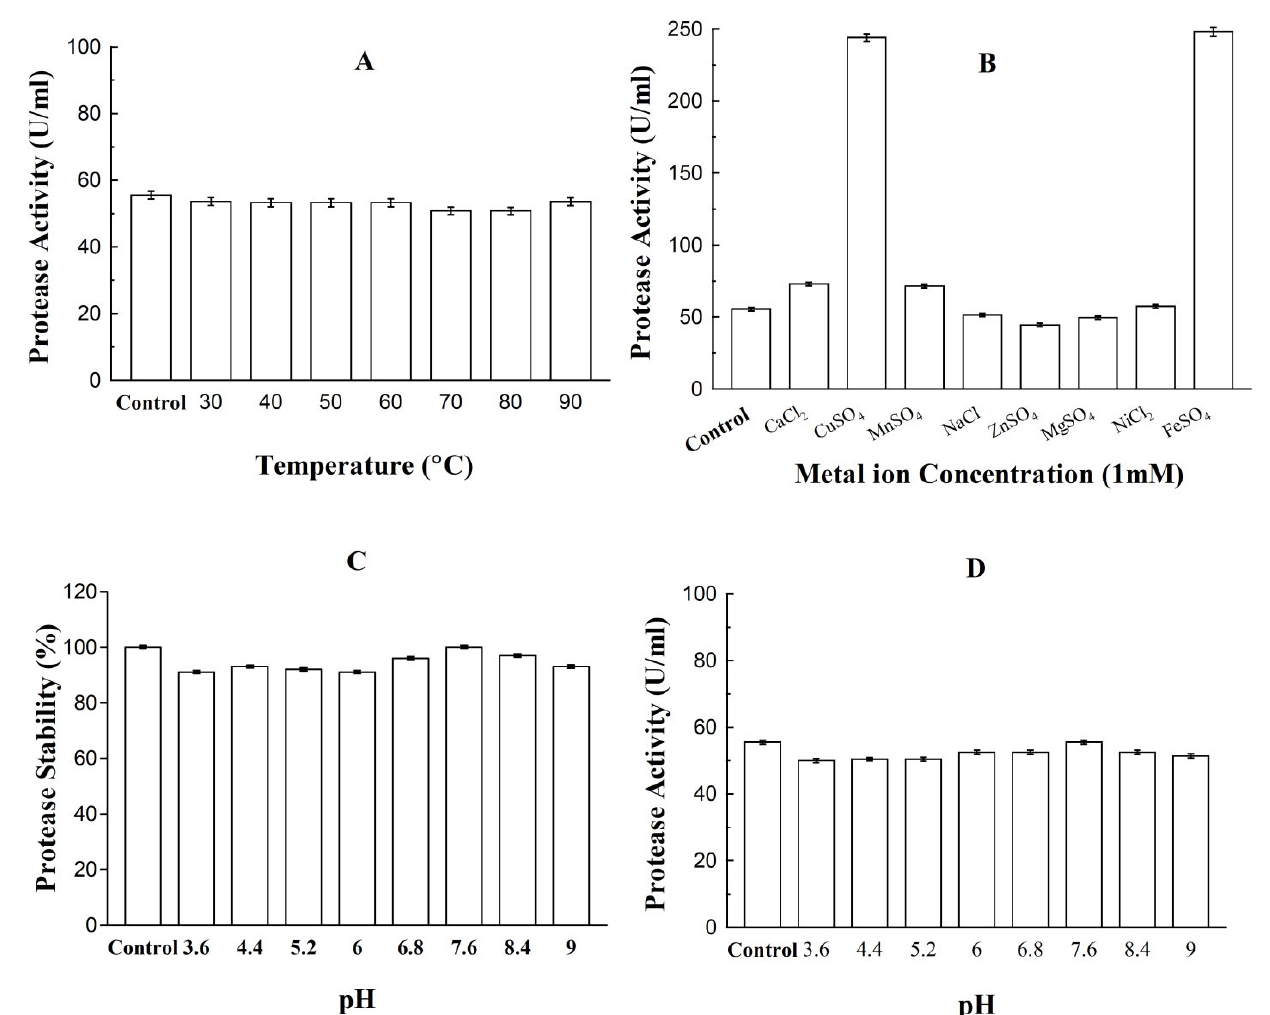
Figure 6. Characterization of semi-purified enzyme extracted from compost soil isolate Bacillus subtilis D3L/1: Bar represents enzyme activity; ( A ) thermostability of extracellular protease; ( B ) effect of heavy metal on protease activity; ( C ) protease stability under different pH range ( D ): relative activity of protease under different pH range. The statistical significance was p < 0.05.